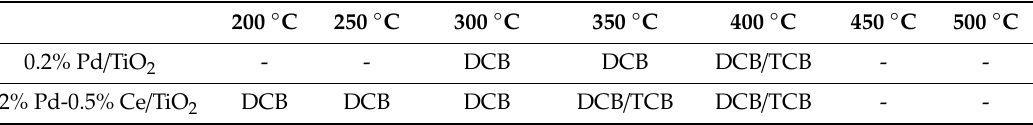
Figure 12. Organic by-products in the outlet effluents (350 °C). ( a ) 0.2% Pd/TiO 2 ; ( b ) 0.2% Pd 0.5% Ce/TiO 2. Table 3. Formation of organic by-products at different temperatures.